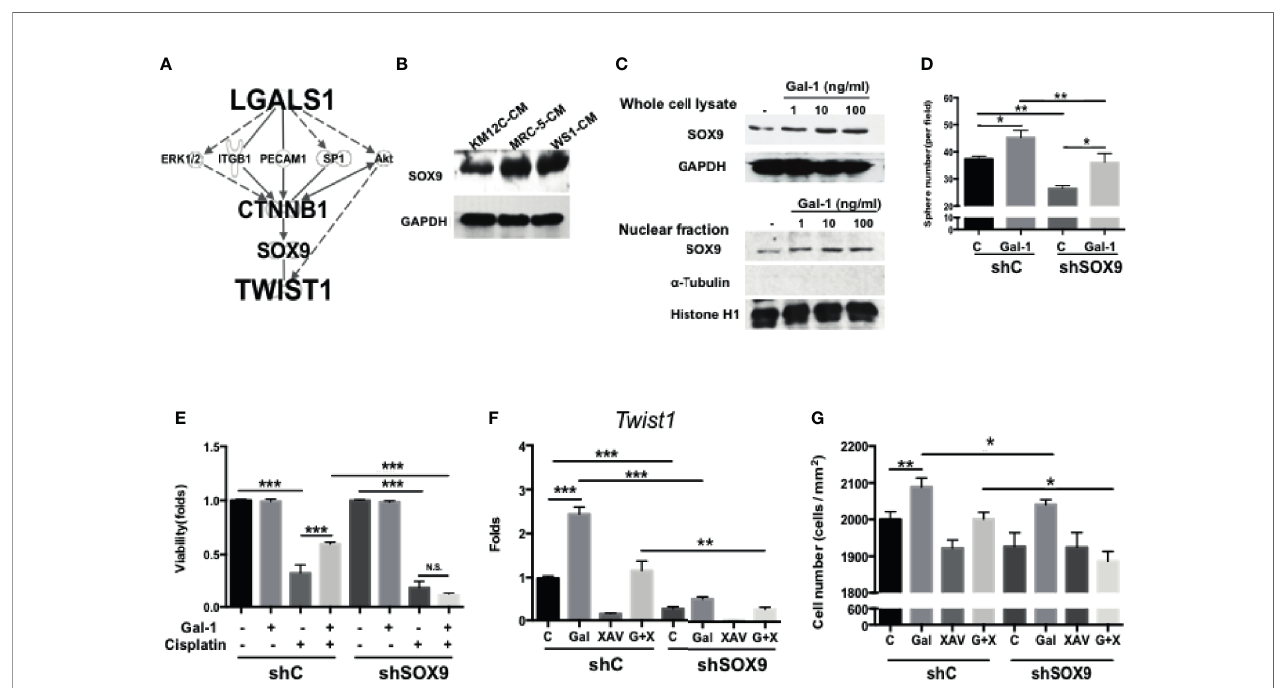
FIGURE 5 | SOX9 is a critical mediator involved in Gal-1-induced upregulation of b -catenin activity and CIC features. (A) Ingenuity Pathway Analysis (IPA) for the prediction of candidate mediators within the LGALS1/CTNNB1/Twist1 axis. IPA database revealed the several major pathways which might be involved in tumor development and metastasis. According to the IPA results and literature review, SOX9 was selected and con fi rmed whether it is the downstream gene of Gal-1 by Western blot. (B) Western blot for the analysis of SOX9 protein levels in KM12C after culturing in MRC-5- or WS1-CM; KM12C-CM was used as the control. Internal control: GAPDH. (C) Western blot for SOX9 levels in whole cell lysate (top panel) and nuclear fraction (bottom panel) of KM12C with addition of increasing doses of rhGal-1 for 48 hours; for nuclear protein blot, histone H1 is used as the positive control and a -Tubulin as the negative control. (D) Sphere formation capacity of shC- KM and shSOX9-II-KMC12 (shSOX9-KM) after treating with rhGal-1 (100 ng/ml) for 72 hours. (E) Drug resistance capacity of shC- and shSOX9-KM to cisplatin (25 µM) after pretreatment with rhGal-1 (100 ng/ml) for 24 hours. Cell viability was assessed 48 hours after drug treatment. (F) qPCR analysis for the gene expression of Twist1 in shC- and shSOX9-KM after treatment with Gal-1 (100 ng/ml) and XAV (10 µM). (G) Invasion capacity of shC- and shSOX9-KM with addition of rhGal-1 (100 ng/ml) and XAV (10 µM). All results are shown as the mean ± SEM of three independent experiments. * p < 0.05; ** p < 0.01, and *** p < 0.005 compared to the control. N.S., not signi fi